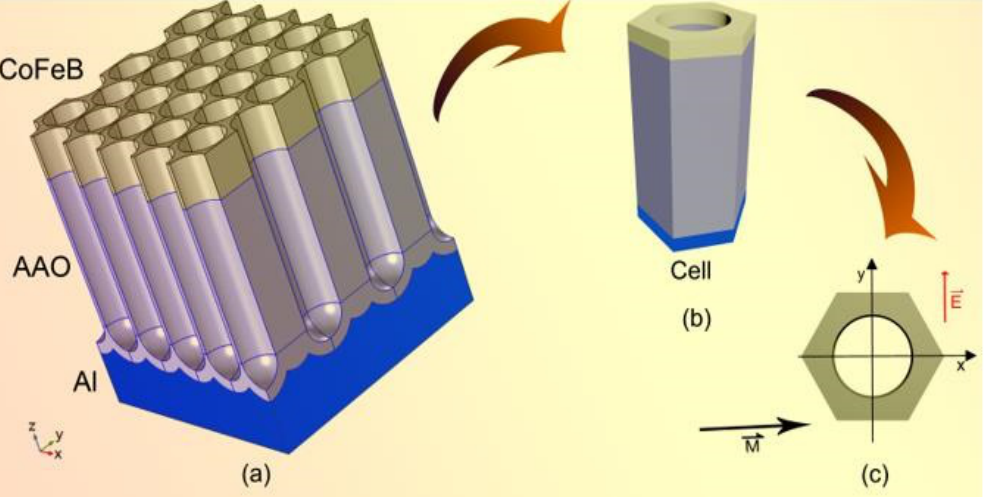
Figure 2. ( a ) Hexagonal honeycomb structure covered with a CoFeB film. ( b ) The periodic cell used to calculate the magneto-optical Kerr signal. ( c ) A schematic illustration of the electric field E⃑⃑ , external magnetic field M⃑⃑⃑ , and the sample surface.